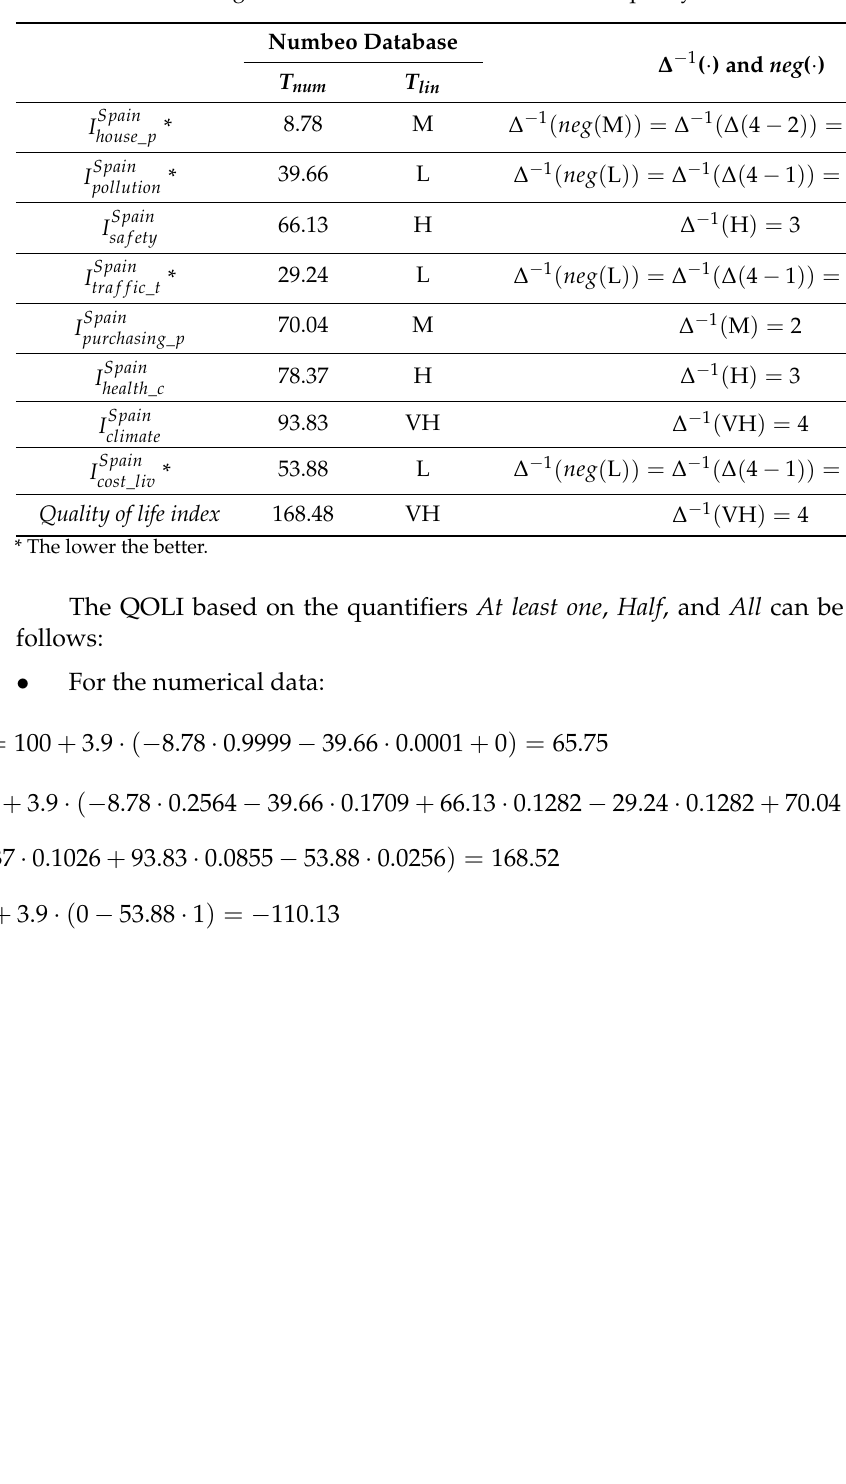
Table 5. Data about eight sub-indicators used to measure the quality of life index in Spain. Numbeo Database T num T lin